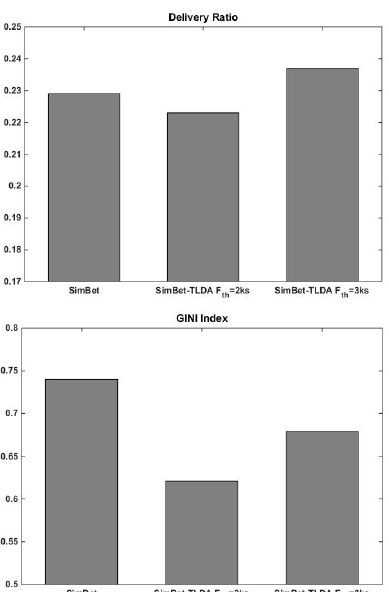
20 of 23 Figure 12. Performance evaluation of SimBet and SimBet-TLDA ( 𝜉 = 0.8) for the Reality mobility scenario. As in the case of BubbleRap, in this case TraLDA is also able to substantially reduce the SimBet’s GINI index, without much affecting other delivery performances. The major purpose of SimBet-TLDA is to enhance traffic load balancing across network nodes, and as seen in Figures 12 and 13 (lower-left), the GINI index performance of SimBet-TLDA can outperform that of SimBet. As previously stated, using binary relationships to calculate node centrality makes a node’s utility relatively constant over